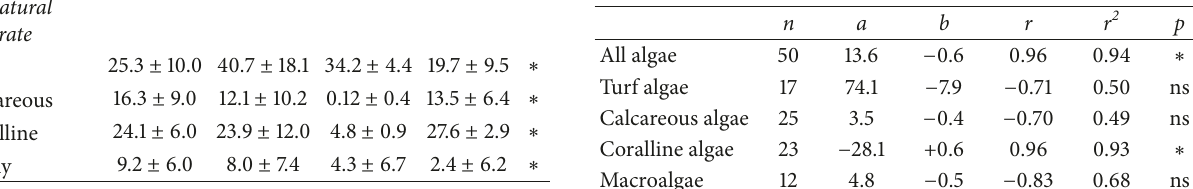
Table 5: Correlation analysis between recruit density and algae types/forms from Kenyan protected lagoons, fitted to the model 𝑦 = 𝑎 + 𝑏𝑥